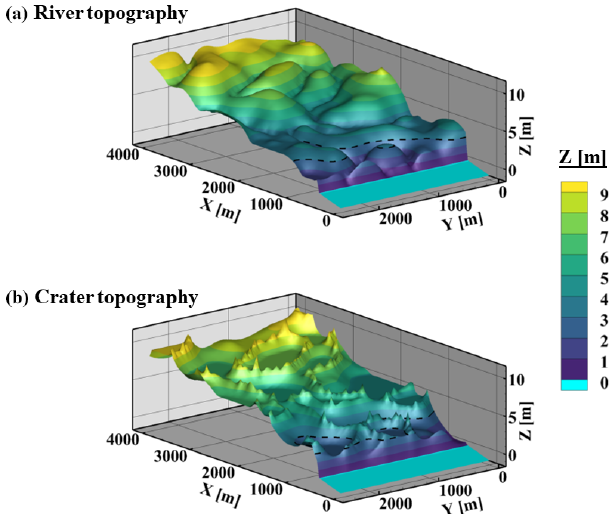
Figure 3. (a) River and (b) Crater topographies as a function of the vertical Z , cross-shore X , and alongshore Y coordinates. Light blue is the offshore bathymetry, and the coastline is at X = 450m. The overall slope accounting for macro-topography is the same for both topographies, and the average elevation at X = 4000m is ∼ 5m, making it a slope of 5 / 3550 ≈ 0 . 0014. The dashed black curve marks the Z = 3m contour, which is equal to the maximum surge- induced sea level